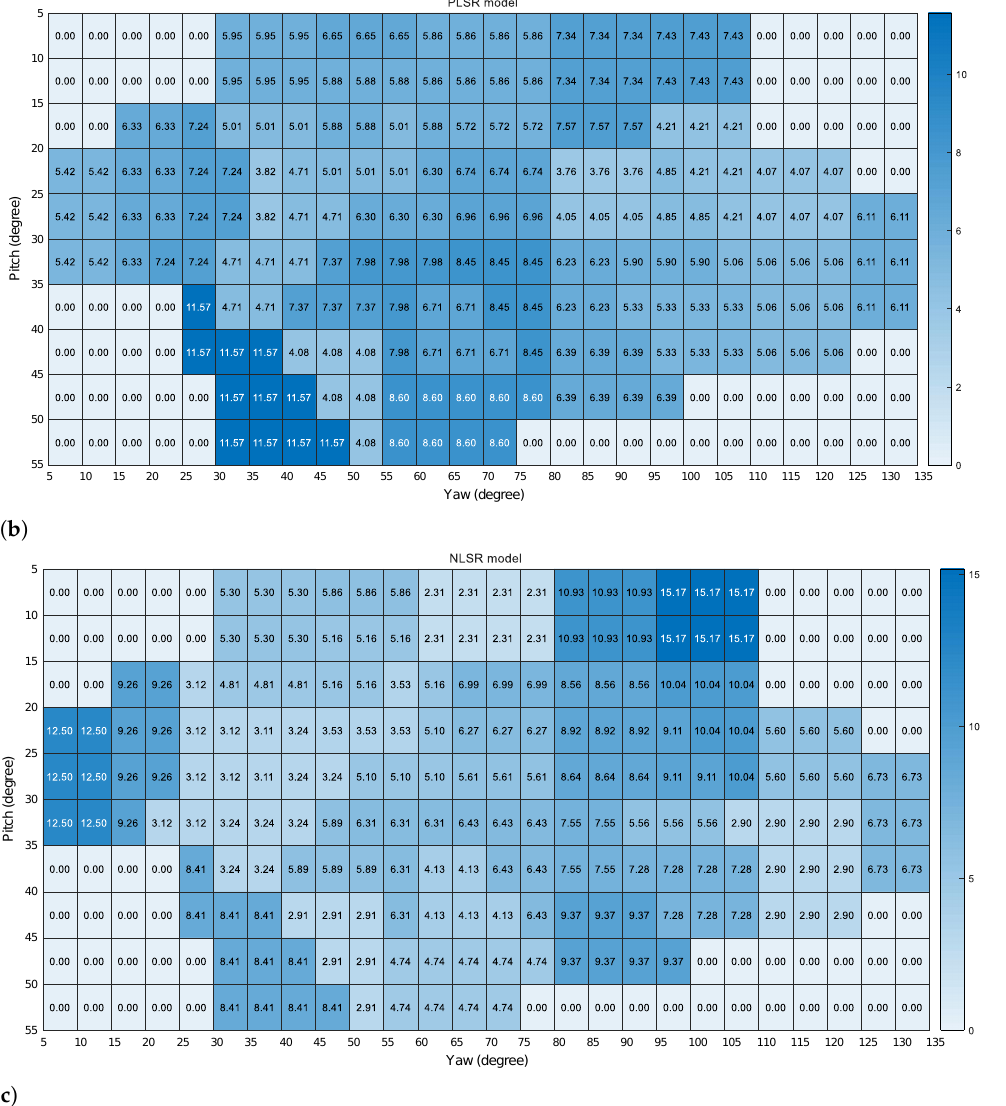
Figure 6. Error reduction of the pre-trained model in the horizontal and vertical directions of the image plane, the proposed method with ( a ) GPR model; ( b ) PLSR model; and ( c ) NLSR model. Each block is a square with angles of 5 × 5. The color of the block indicates the increase level of the gaze estimation